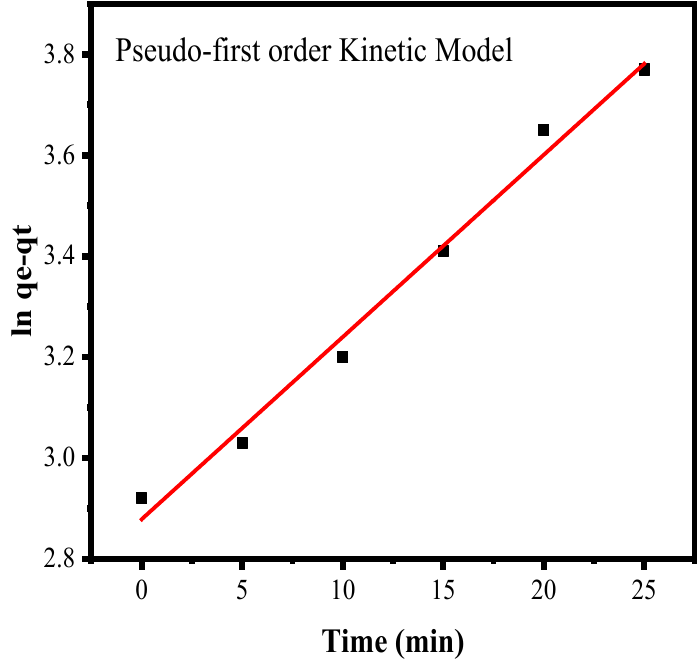
Figure 10. Pseudo-first order kinetic model for photocatalytic activity.